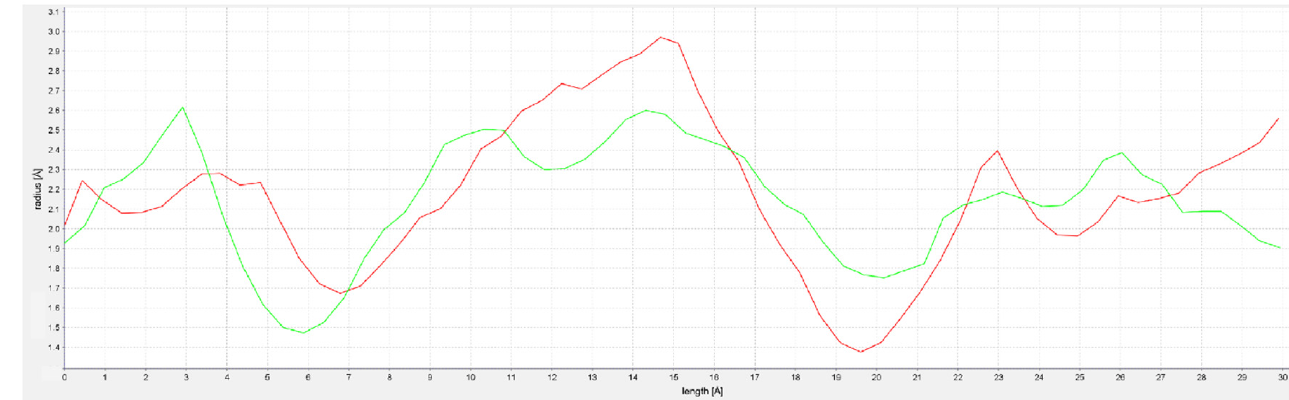
Figure 4. Comparison of MA channels of rat (red) and human (green)